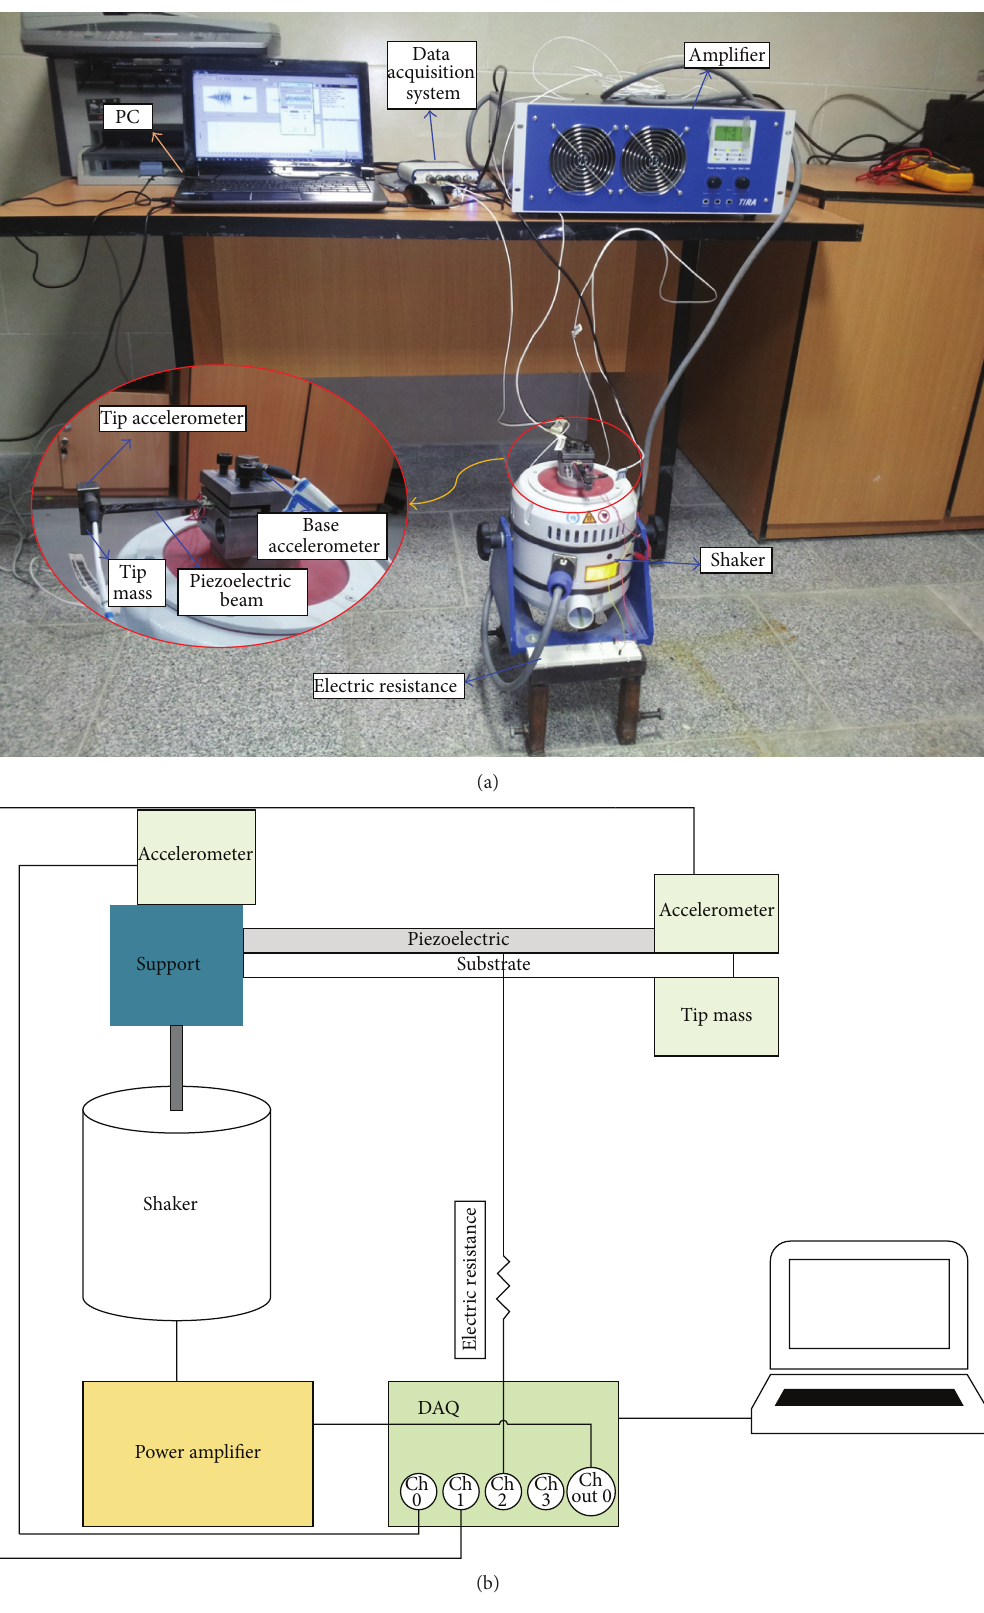
Figure 4: (a) Experiment equipment setup and (b) schematic of the experimental